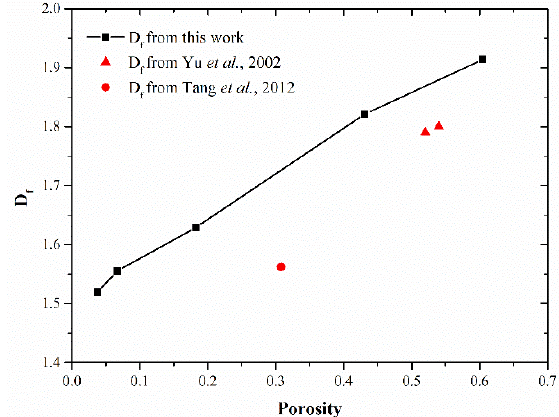
Figure 10. Evolution of D f with porosity from this work and Refs. [50,49].